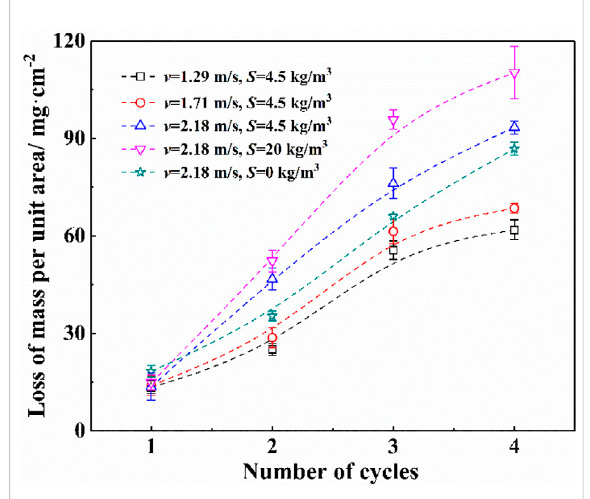
FIGURE 5 Variation of steel sample residual mass with cycle number (each cycle contains corrosion and erosion process).